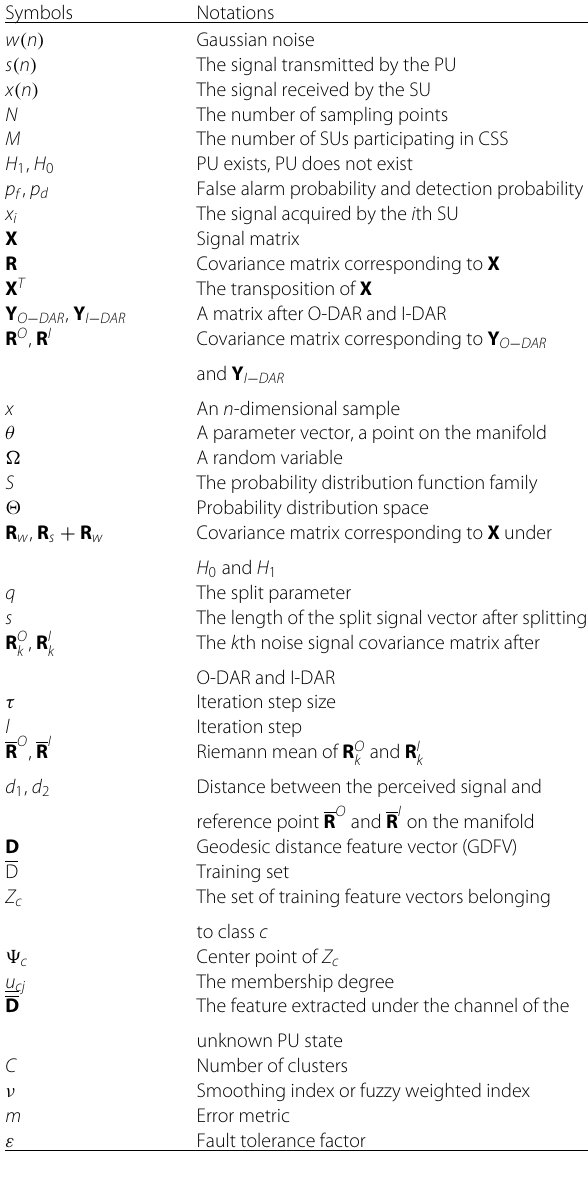
Table 1 Summary symbols and notations